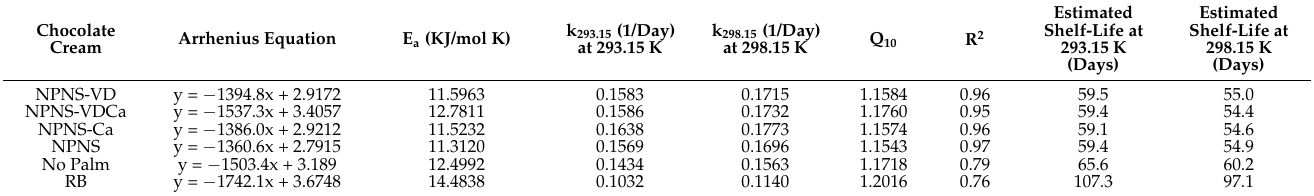
Table 4. Arrhenius equations, activation energy (E a KJ/mol K), rate constant at 293.15 and 298.15 K (k 293.15 and k 298.15 ), Q10, correlation coefficient value (r 2 ), and shelf-life at 293.15 and 298.15 K esti- mated for different chocolate spread samples.